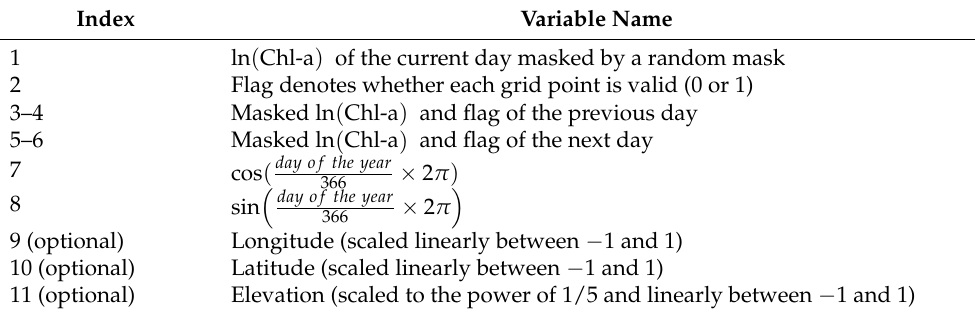
Figure 4. Schematic flowchart for the workflow of model training. Table 1. The total list of input variables. Variables of index 9–11 are optional in different